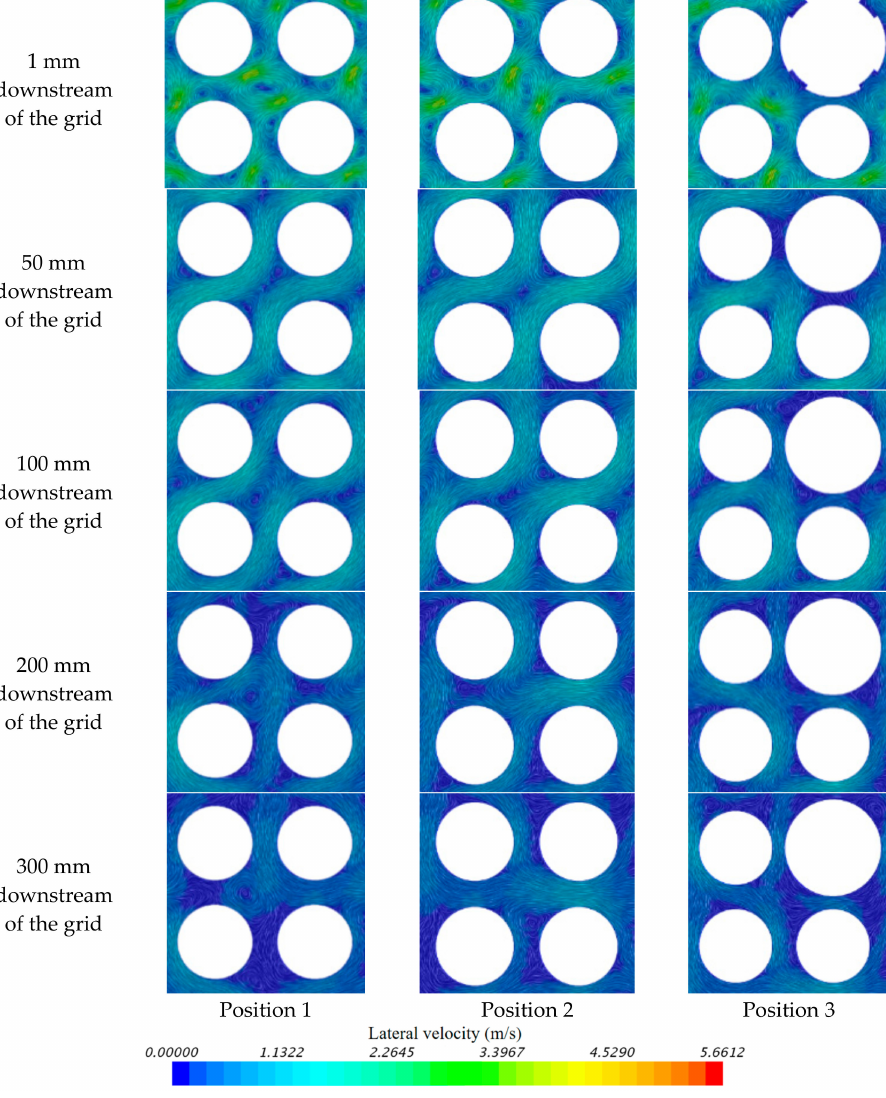
Figure 18. Cross-sectional lateral velocities at di ff erent